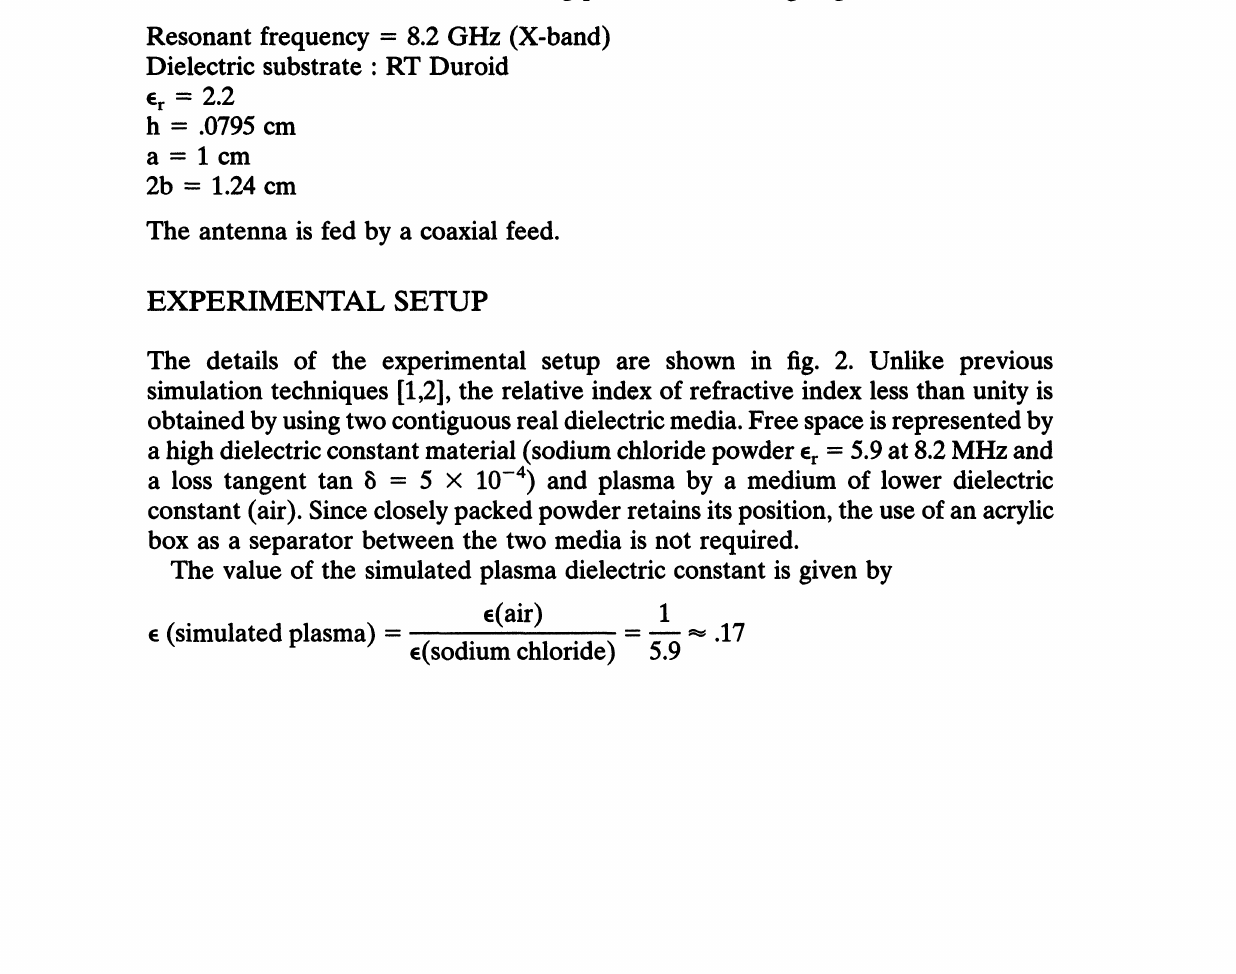
FIGURE 1 Geometry of curved rectangular microstrip